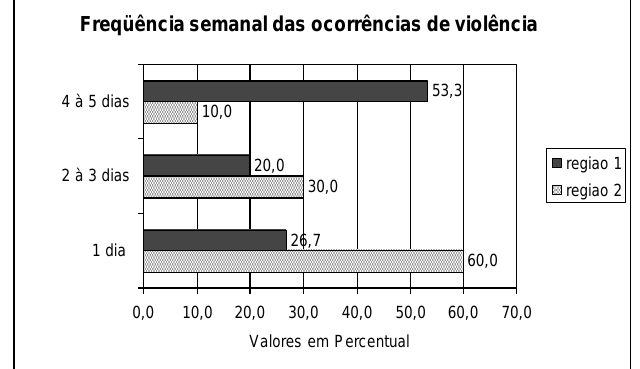
Figura 2. Frequência semanal das ocorrências de